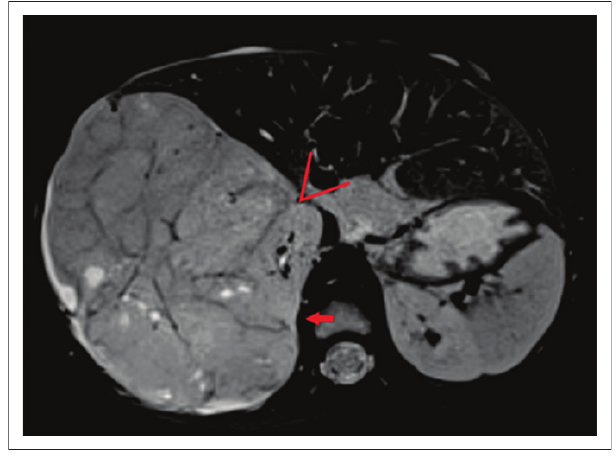
Source : Unedited images were obtained from the radiological information system database (RIS) of Tygerberg hospital while editing and markers seen were added by the author. FIGURE 5: Axial fat-suppressed T2-weighted magnetic resonance image of a large nephroblastoma arising from the inferior pole of right kidney. The claw sign is positive at the posterior kidney–tumour interface (red arrow). However, there is infolding and an acute angle at the anterior kidney–tumour interface (red marker). In conflicting cases, a positive claw sign was